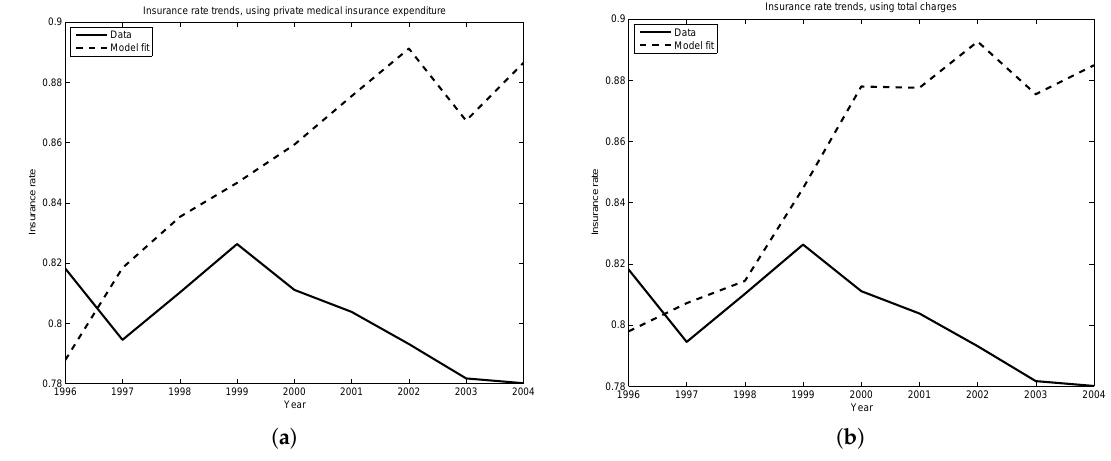
Figure 4. Predicted trends are consistent across